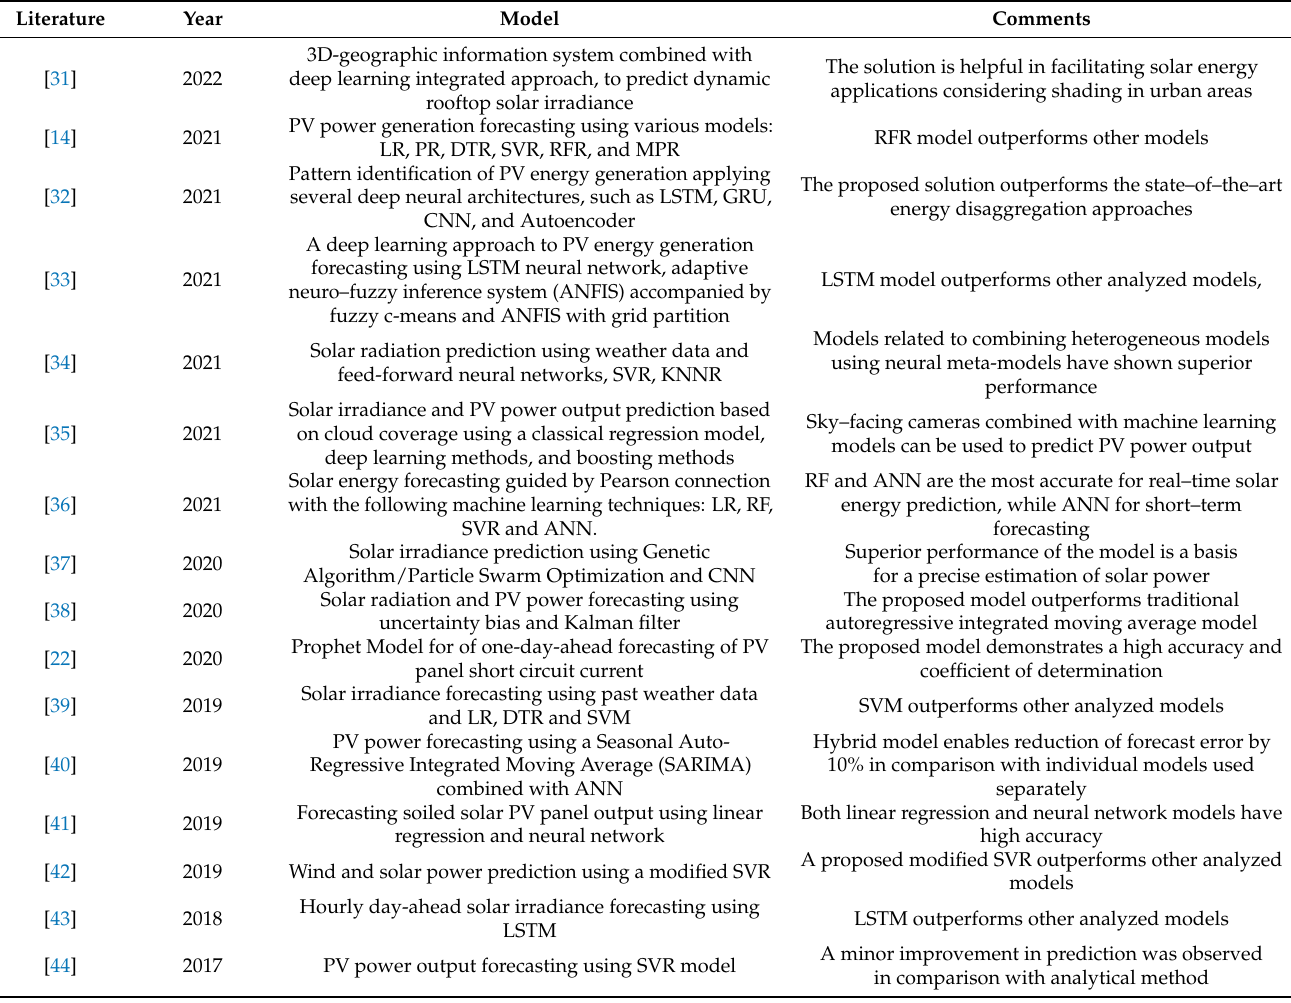
Table 1. An overview of recent work on machine learning applications for PV panel output